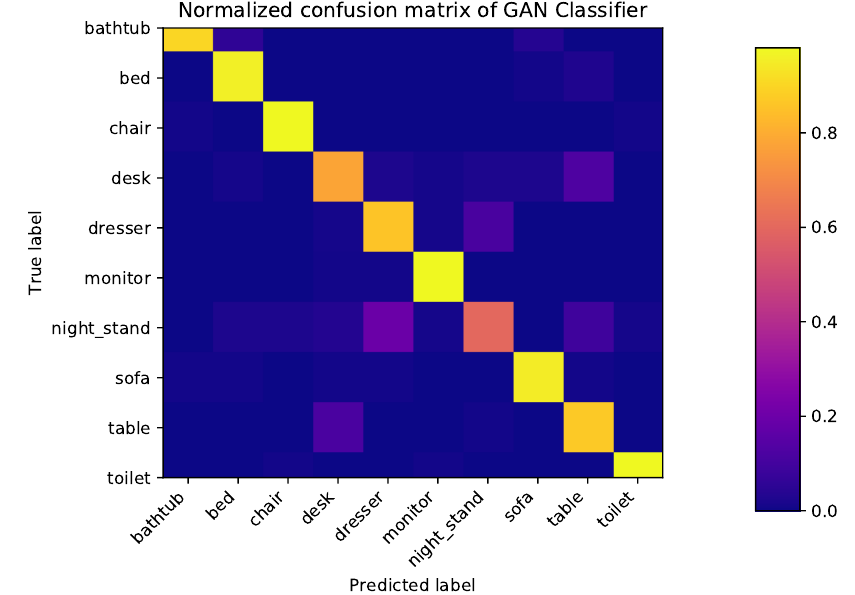
Figure 6. Confusion matrix of the GAN classifier evaluated on the ModelNet10 testing set. The values are normalized in [0, 1] range per each true label. It shows the most misclassified classes are desks, tables, and nightstands. This can most likely be attributed to low resolution and non-identical scale of the voxel models caused by the voxelization tool scaling the mesh models to fit the voxel grid